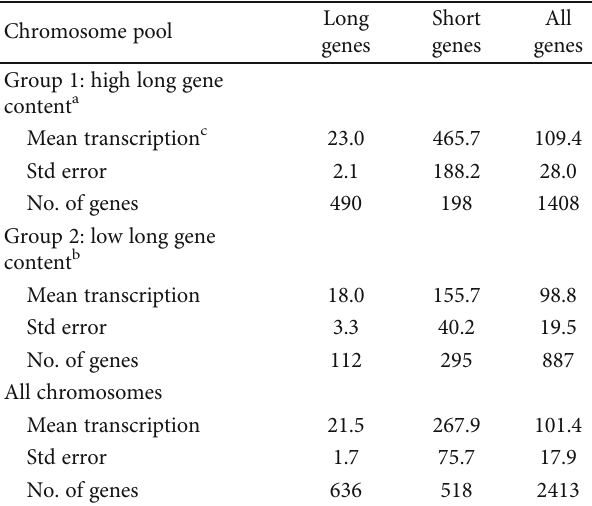
Table 1: Gene expression in group 1 compared to group 2 chromosomes.